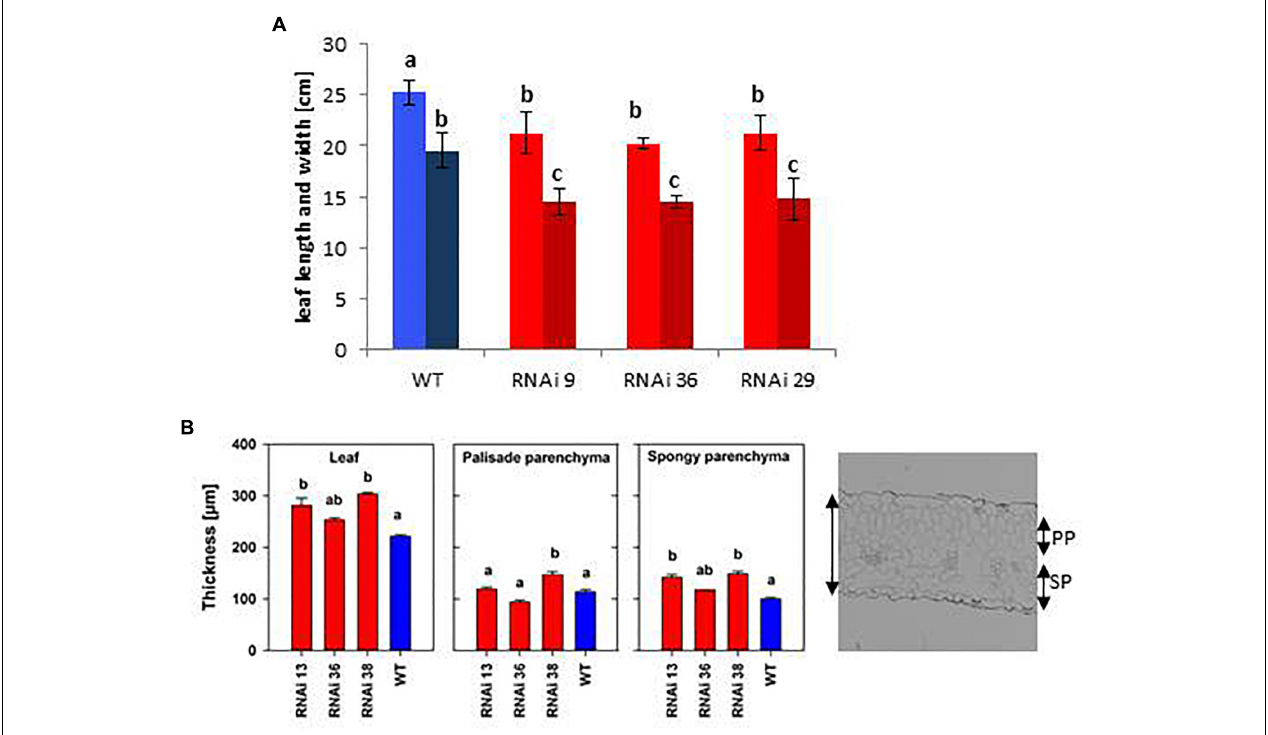
FIGURE 2 | Leaf morphological parameters of NtMSBP1 -RNAi tobacco plants. (A) Leaf length (light colored) and width (dark colored) and (B) total thickness of leaves, of palisade (PP) and spongy parenchyma (SP) are shown. Mean values and standard deviations of wild type plants and MSBP1 -RNAi lines are presented for 4–5 replicates. Significant differences between values of the RNAi lines and wild type plants are indicated by different letters according to one way